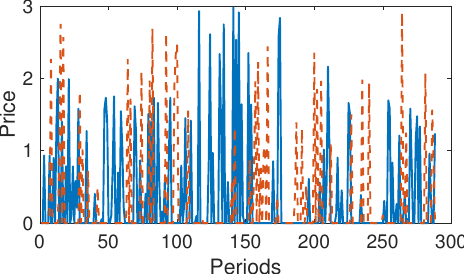
Figure 5. The solid line shows the penalty price ($ per MW) for drawing power and the broken line shows the penalty price ($ per MW) for injecting power. The storage unit of household is now uniformly distributed between [0,10] kwh.